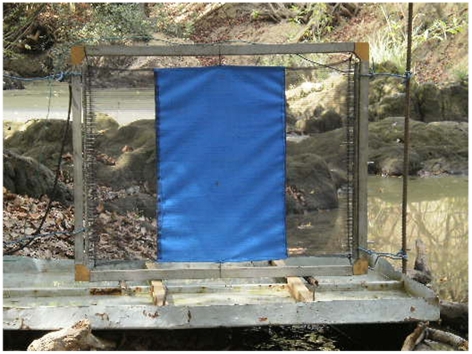
Example of a target design used for comparison.A 0.75 m wide×0.50 m high net-blue-net target (37.5 cm×50 cm blue surrounded by 2 pieces of net of 18.75 cm×50 cm each) inside an electric grid mounted on a fly collection tray.